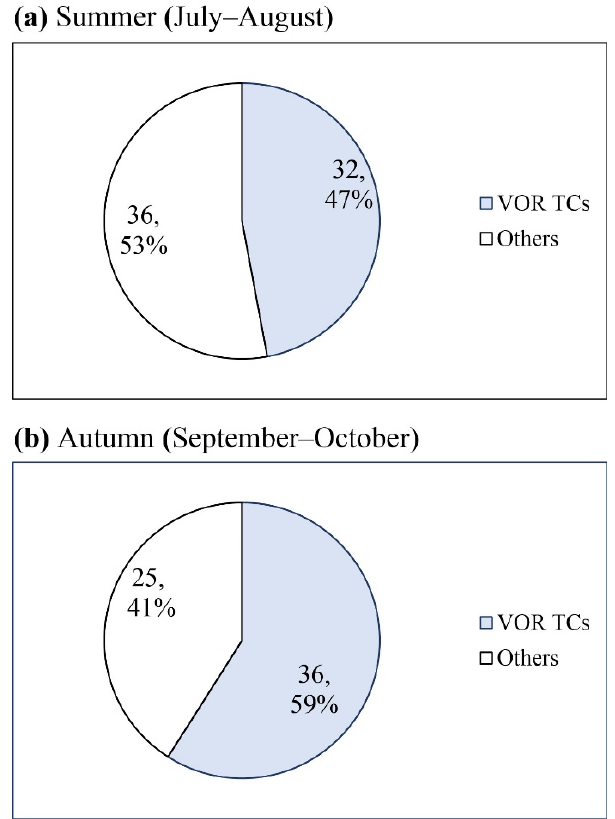
Figure 2. Proportions of VOR TCs (blue) and other Environmental TCs (white) to all Environmental TCs: ( a ) TCs in summer (July–August) and ( b ) TCs in autumn (September–October) from 2003–2017.